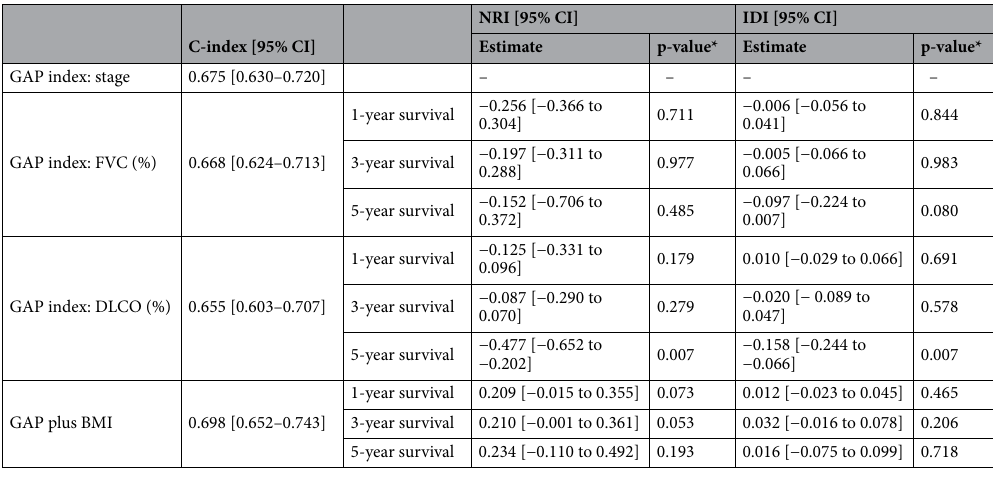
Table 5. Additional predictive values of GAP plus BMI at initiations of antifibrotic therapy in patients with IPF. *Compared with GAP index. CI confidence interval, NRI net reclassification improvement, IDI integrated discrimination improvement, GAP Gender-Age-Physiology, FVC forced vital capacity, DLCO diffuse capacity of the lung for carbon monoxide, BMI ; body mass